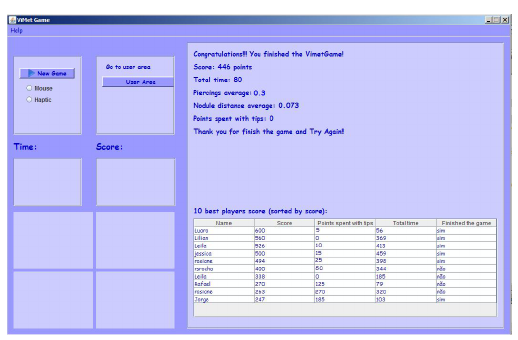
Figure 6. Interface of users’ history.